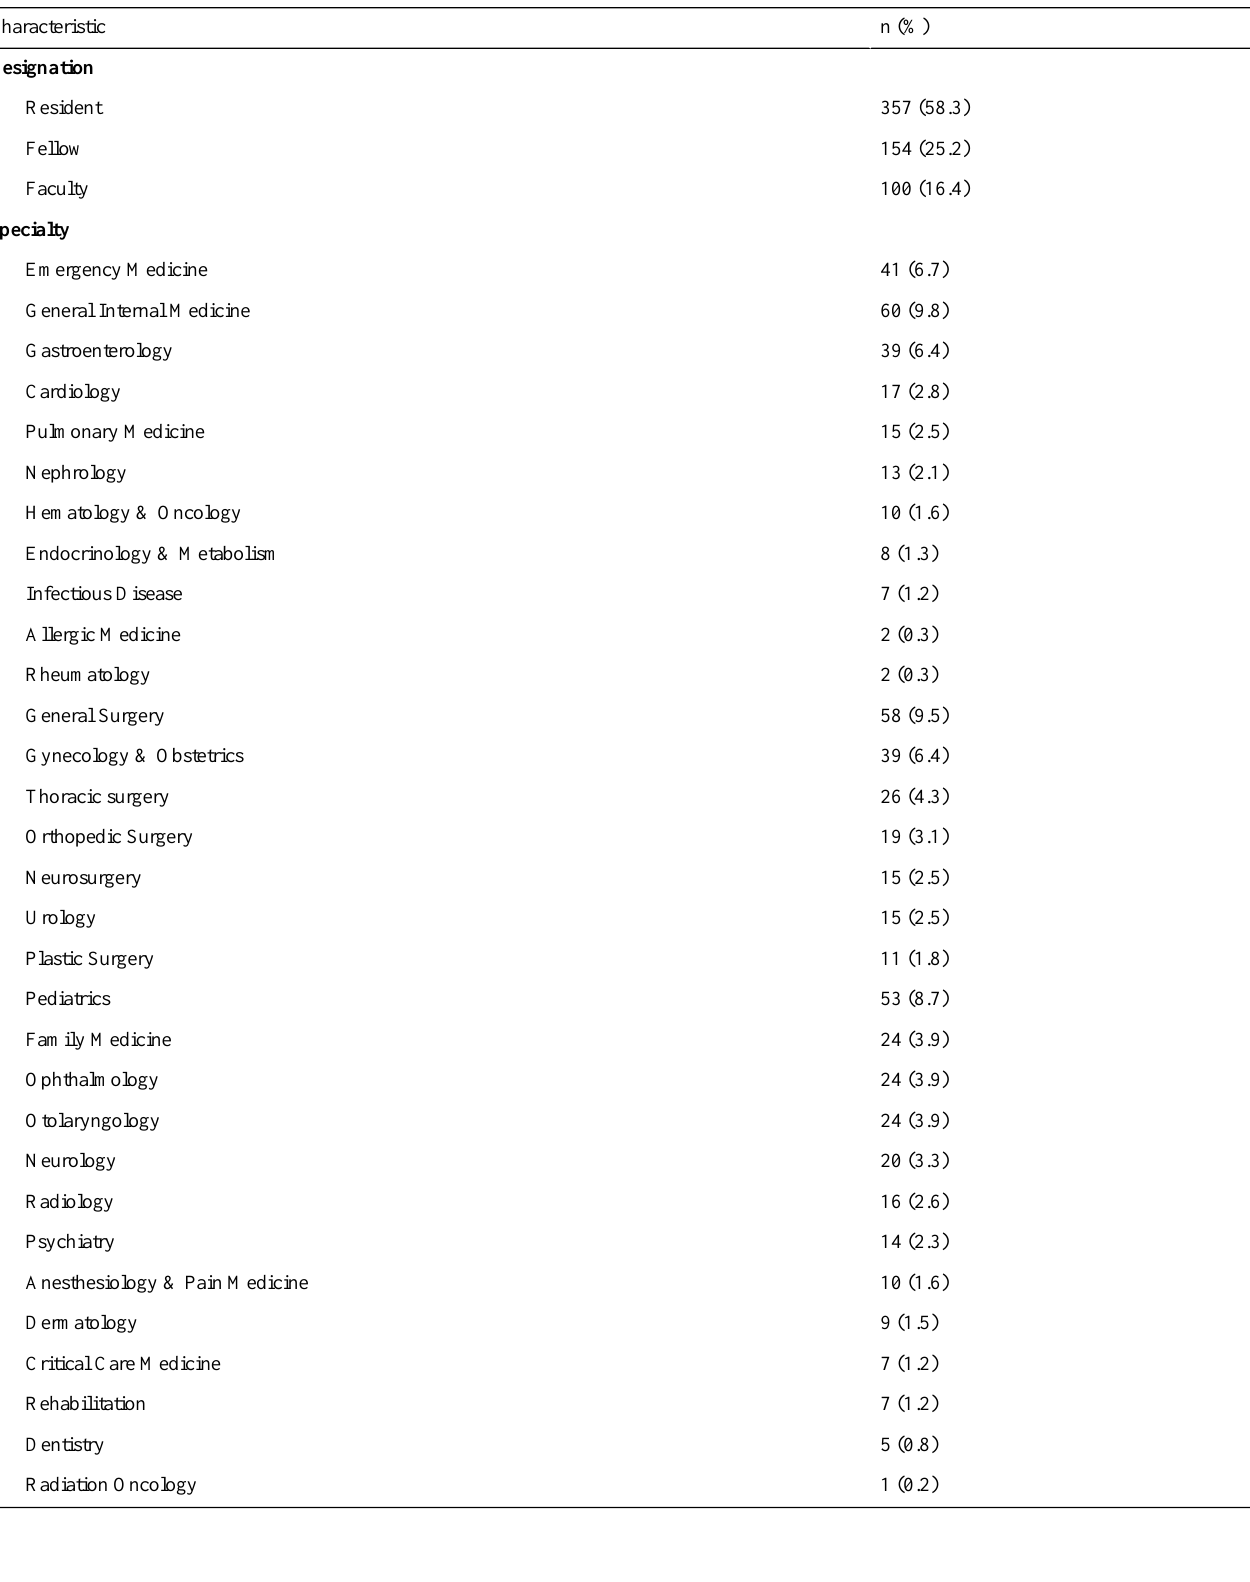
Table 2. Physician characteristics